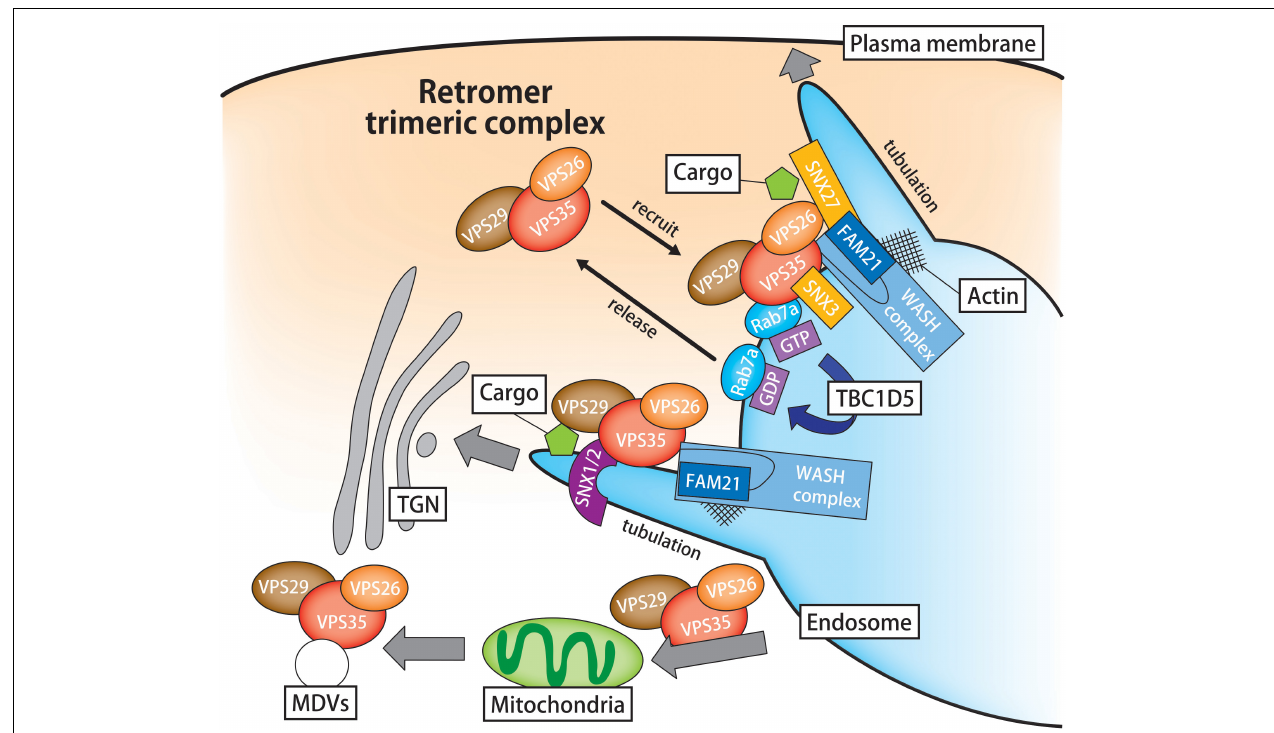
FIGURE 1 | Schematic illustration of the retromer-mediated sorting pathway. Retromer is a hetero-trimeric protein complex composed of VPS26, VPS29, and VPS35. In cooperation with its associated proteins, the retromer sorting machine plays a primary role in the retrograde cargo trafficking from the endosomes to the TGN or plasma membrane. In the first step of retromer-mediated cargo transport, the retromer core is recruited to the endosomal surface under the control of Rab7a and SNX3. Because the endosomal recruitment of retromer complex largely depends on Rab7 activity, the inactivation of Rab7a by TBC1D5 promotes the release of retromer from endosomes. Lipid membrane deformation is crucial for intracellular trafficking and organelle remodeling. In the endosomal microdomain, the WASH complex modulates the process of endosomal tubulation through the activation of actin nucleation and polymerization. In addition to endosomal transport, retromer participates in the mitochondria dynamics through the cargo trafficking from the endosomes to the mitochondria and MDV-mediated trafficking. VPS, vacuolar protein sorting; TGN, trans -Golgi network; SNX, sorting nexin; TBC1D5, TBC1 domain family member 5; WASH, Wiskott-Aldrich Syndrome protein and scar